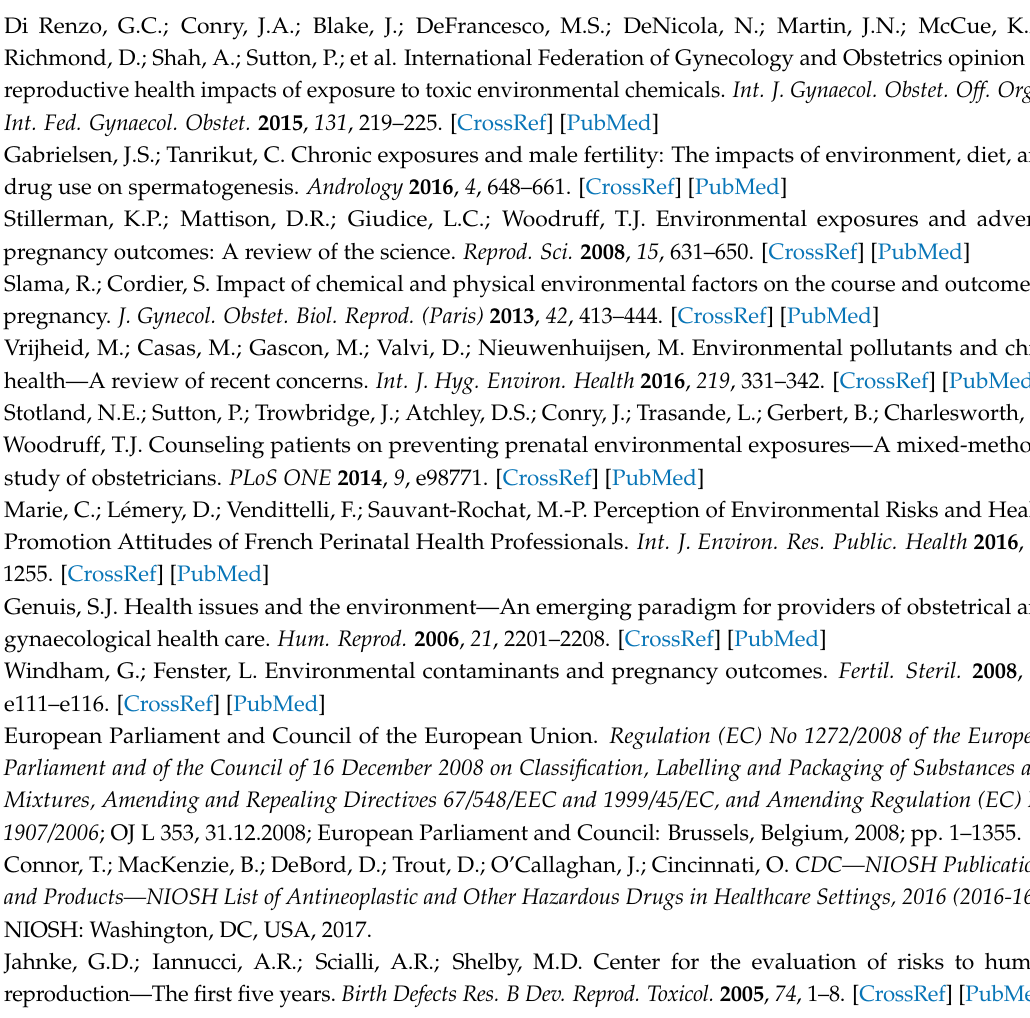
Table S1: Full list of environmental chemical hazards on